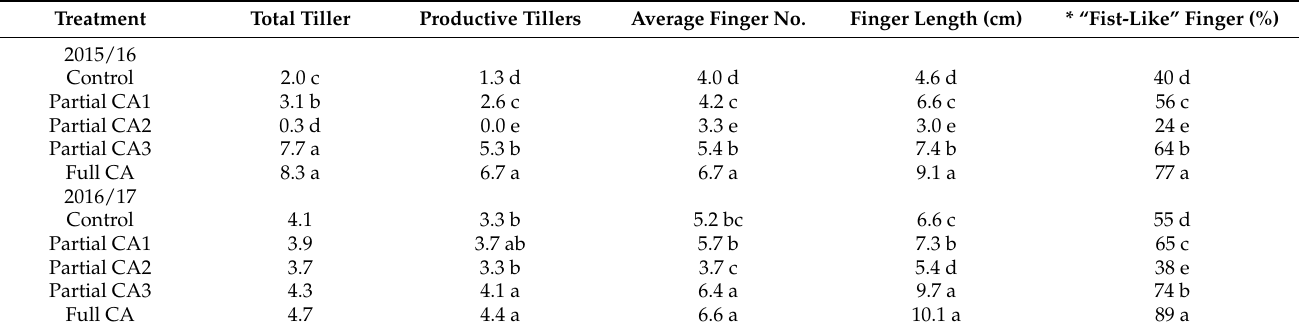
Figure 3. Durations of the emergence (from sowing to emergence), vegetative stage (seedling emergence to ear formation) and reproductive stage (silking to physiological maturity) of the finger millet crop with conventional tillage (control), conventional tillage + mulch, reduced tillage only, reduced tillage + mulch and reduced tillage + mulch + intercropping with cowpea treatments in 2015/16 and 2016/17. Table 2. Agronomic performance of finger millet with conventional tillage (control), conventional tillage + mulch (partial CA1), reduced tillage only (partial CA2), reduced tillage + mulch (partial CA3) and reduced tillage + mulch + intercropping with cowpea (full CA) treatments in 2015/16 and 2016/17 in 2015/16 and 2016/17 cropping seasons.